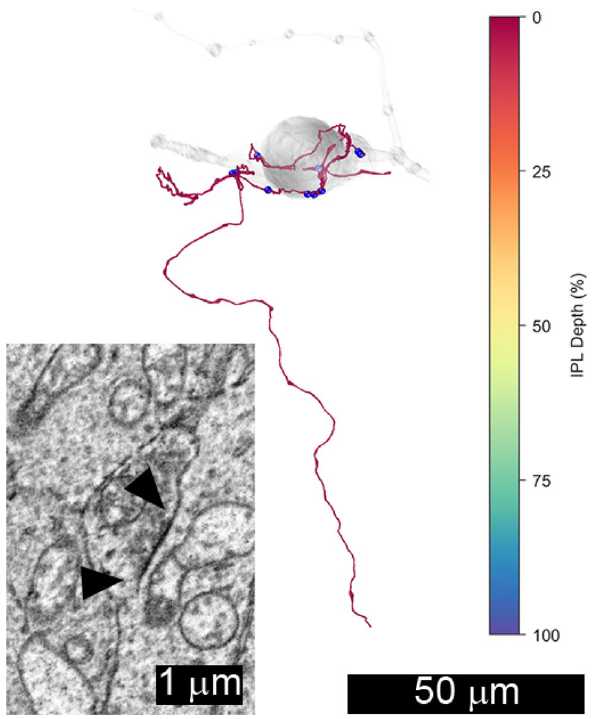
Figure 4. Amacrine cell axon 5560 from the inferior volume was reconstructed. Note its varicose axon and its terminals in the outermost stratum of the inner plexiform layer, S1 (red). It made 12 synapses ( ● ) onto the soma and primary dendrites of ipRGC 1178 (grey). Based on its morphology, it was tentatively identified as an axon of a dopaminergic amacrine cell. The inset shows a typical synapse ( ▲ ) from 5560 onto 1178.